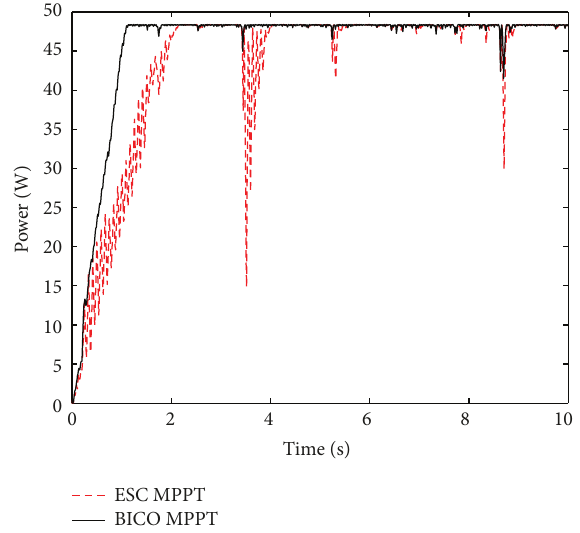
Figure 11: Comparison of power tracking in BICO MPPT and ESC MPPT.